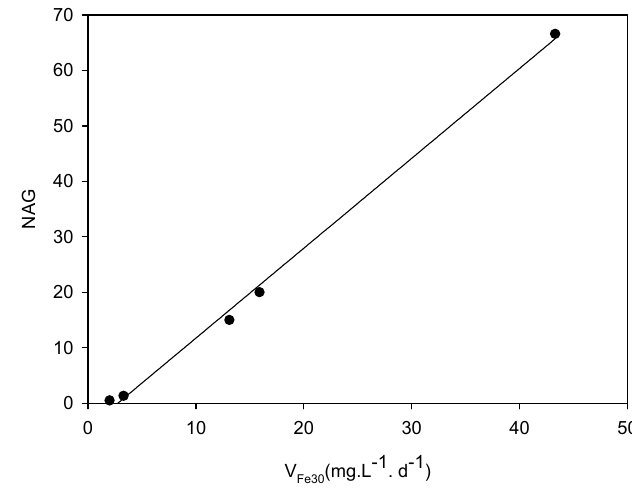
Figure 6. Biooxidation rate vs. NAG pH of the samples.